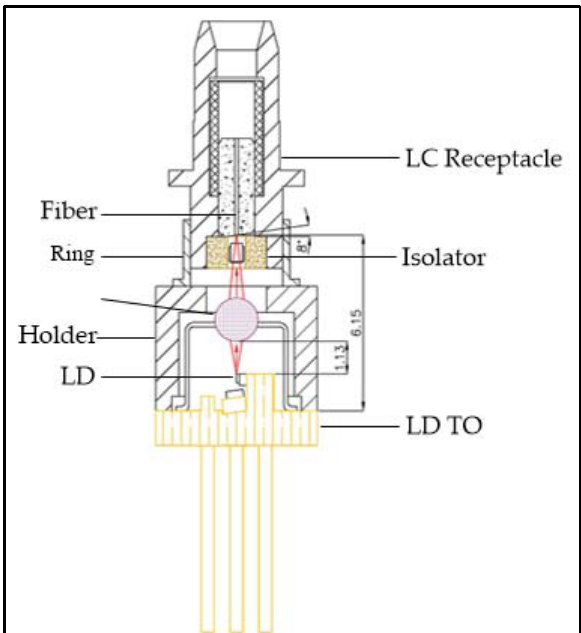
Figure 2. Structure of TOSA.